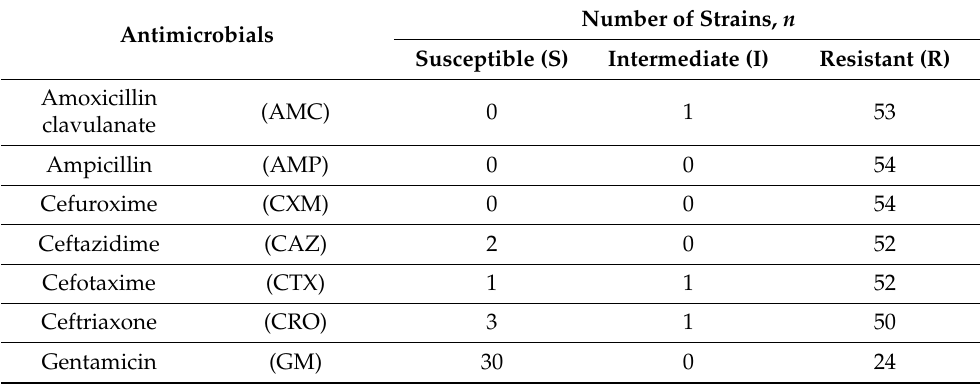
Table 3. Antimicrobial sensitivity of all 54 strains via the automated Vitek ® 2